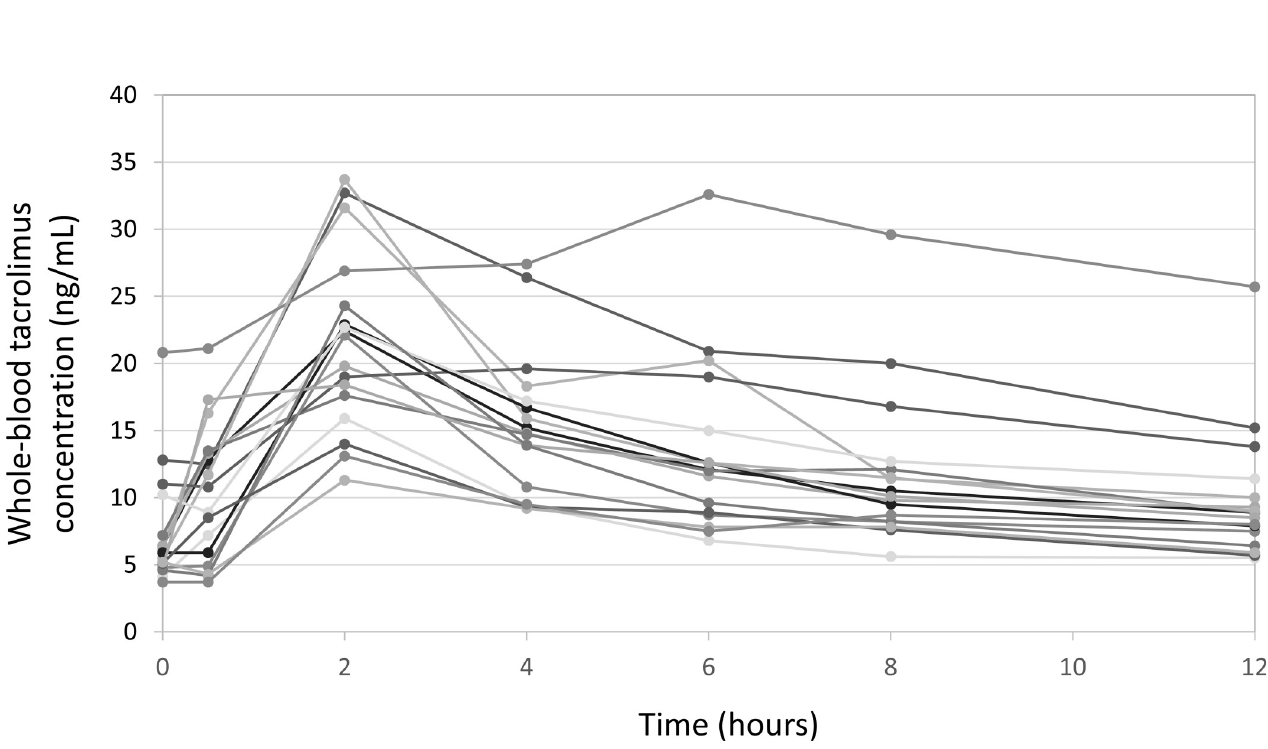
Fig 5. A total of 17 tacrolimus concentration-time curves completed with data from the 5 validation group patients. The x-axis represents time points after oral administration of once-daily tacrolimus. The y-axis represents the whole-blood tacrolimus level. Blood tacrolimus concentrations rose to C max at 2 hours post-administration and gradually decreased